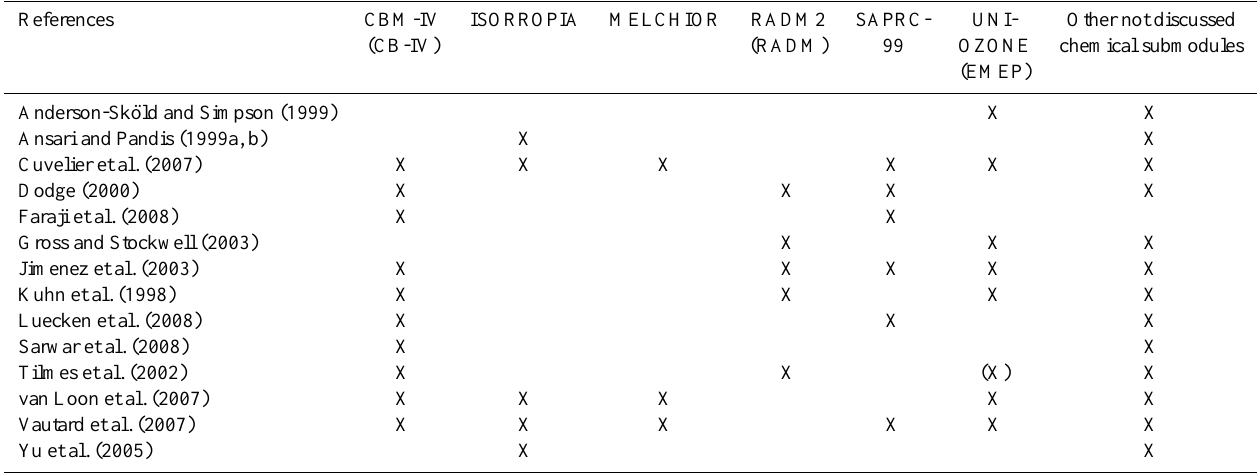
Table 5. Comparison studies of the various chemical